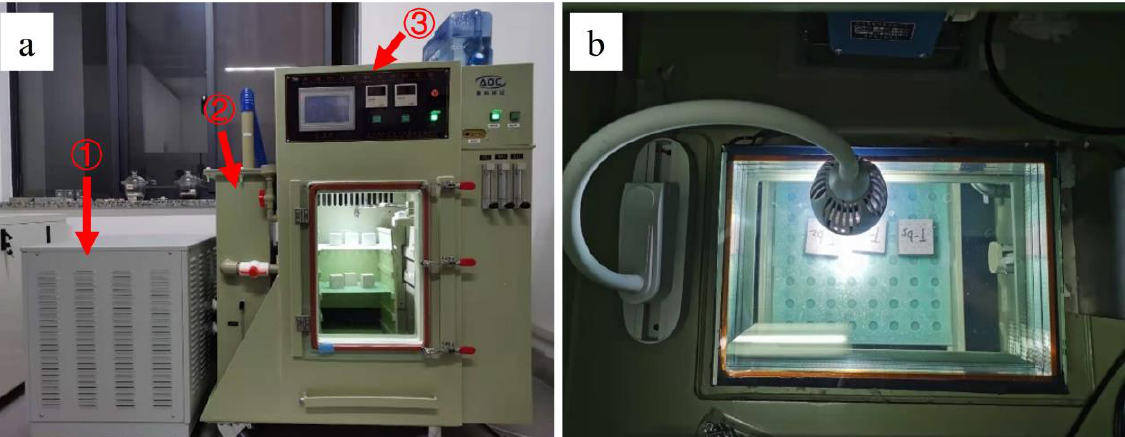
Figure 6. Pictures of test device: ( a ) side view and ( b ) top view. The main components include ① a refrigeration and dehumidification unit, ② an exhaust gas post-treatment system, and ③ a weathering chamber.